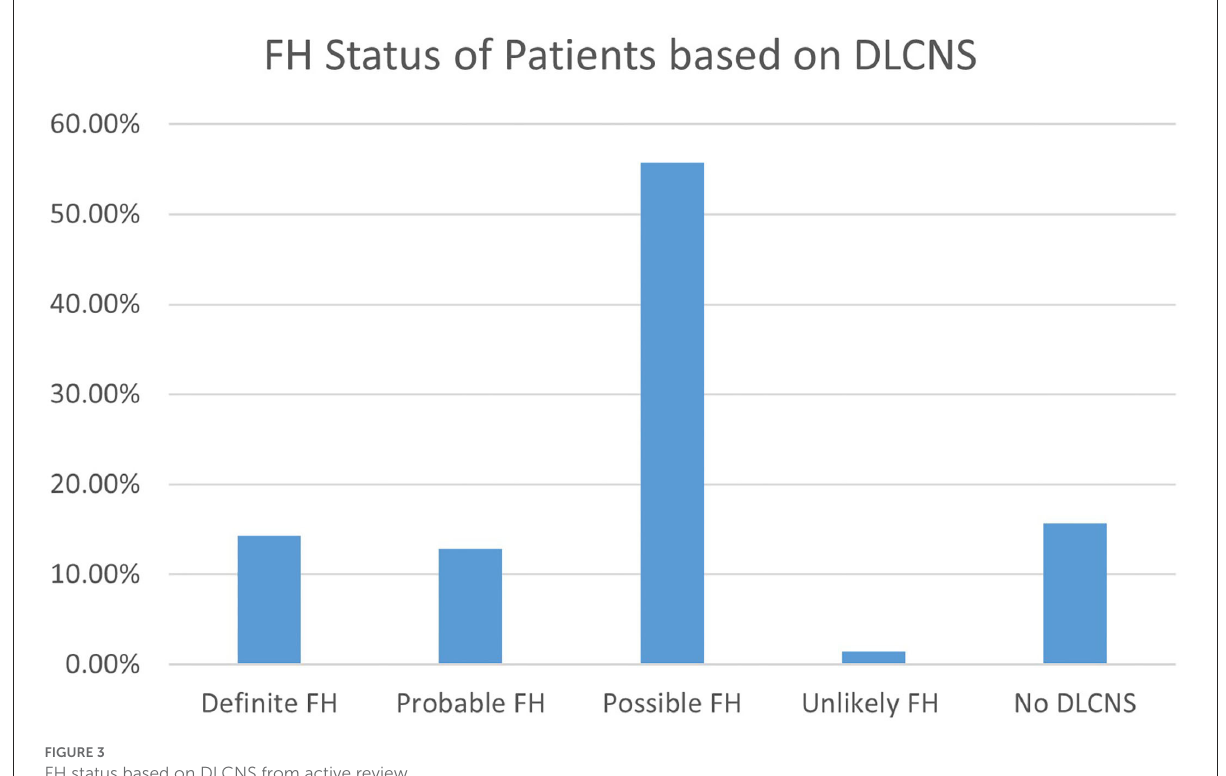
FIGURE3 FH status based on DLCNS from active review.